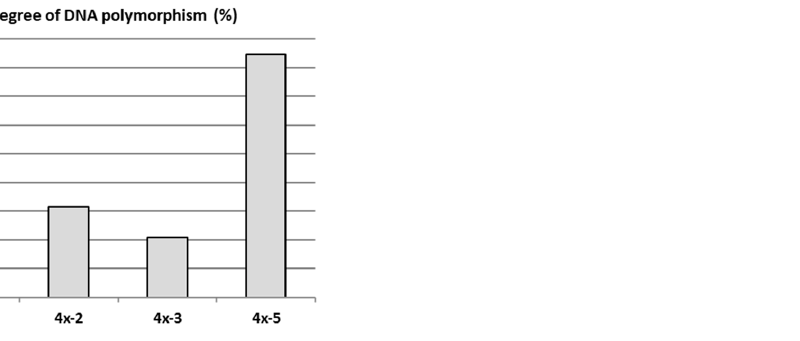
Figure 6. DNA methylation rate of apple diploid donor plant of ‘Free Redstar’ and its tetraploid clones 4x-2 and 4x-3. Error bars represent standard deviations.